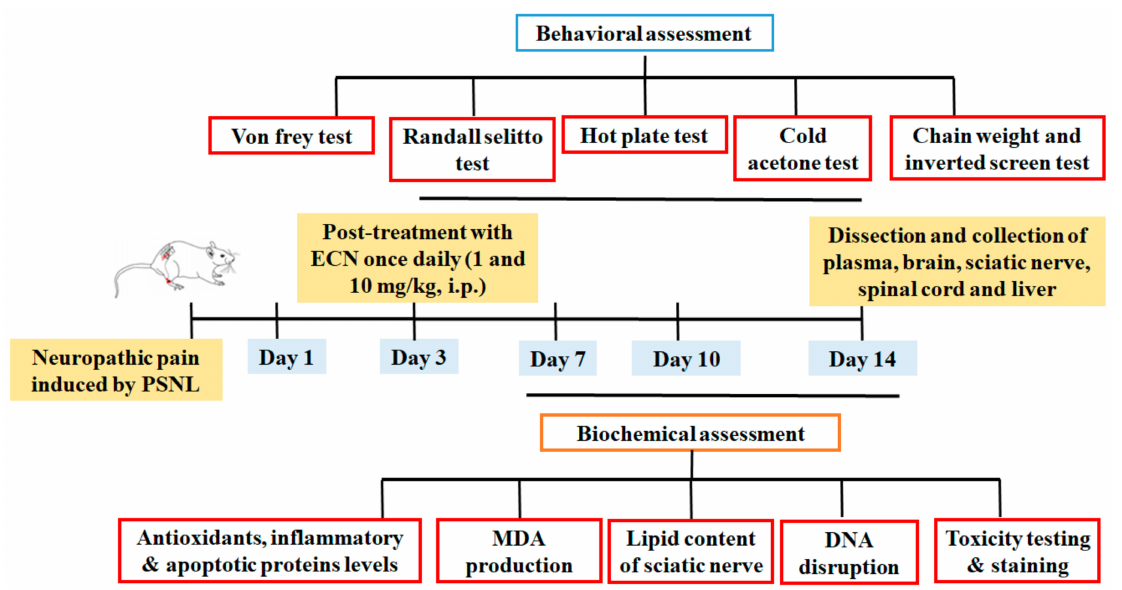
Figure 12. Experimental design for investigating the effect of ECN (1 and 10 mg/kg) against PSNL neuropathic